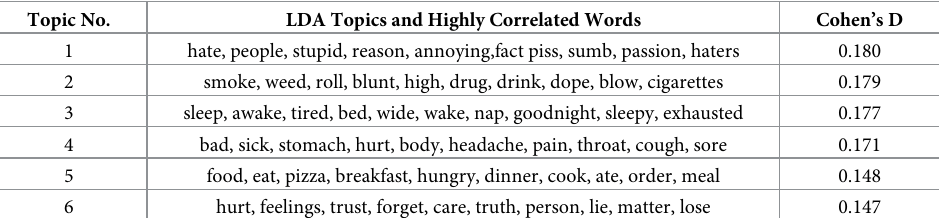
Table 1. Results from LDA analysis for users who express loneliness on Twitter and are between the ages of 18 and 22. Topic No.